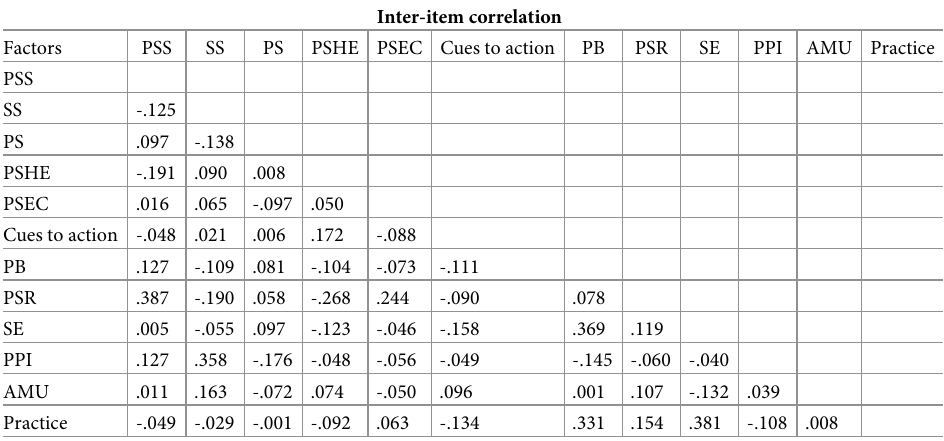
Table 6. Pearson correlation coefficient of variables used to determine adherence to COVID-19 self-protective practices among secondary school students in Jimma town, Jimma, Oromia, Ethiopia,